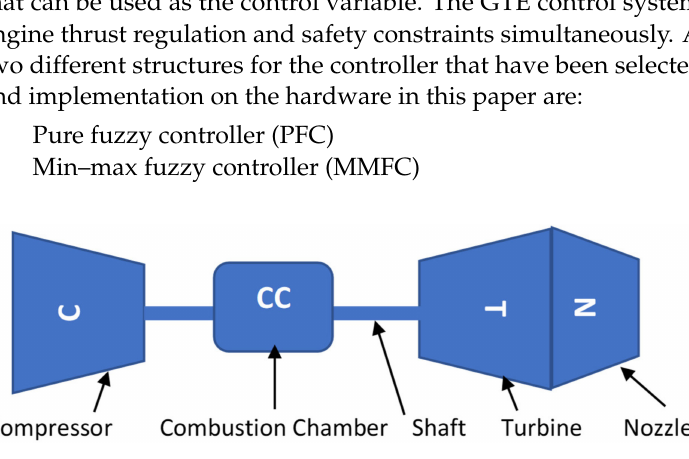
Figure 1. Schematic of single spool turbojet engine (image adopted from